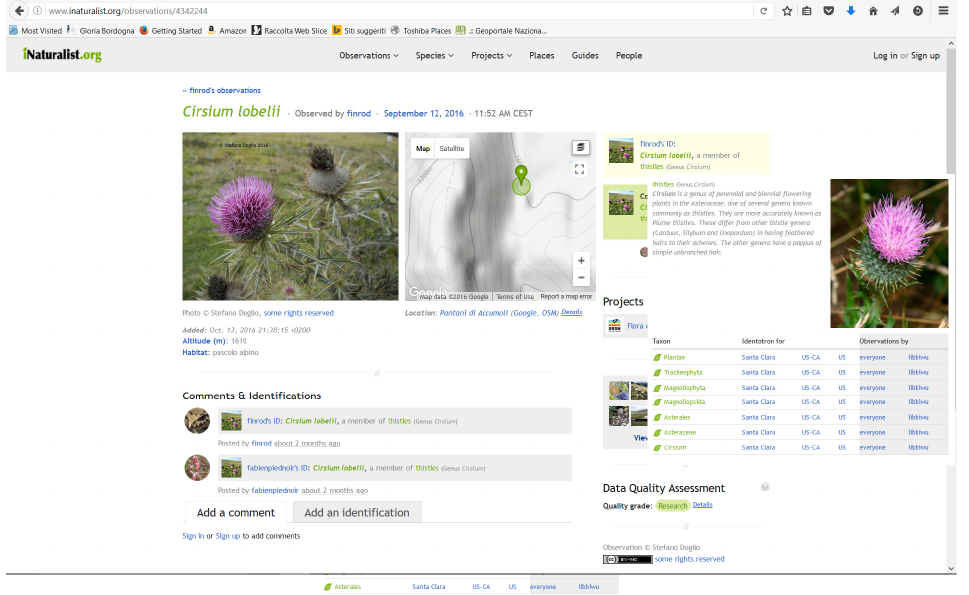
Figure 1. Screenshot of the inaturalist Web geoportal displaying a VGI in the form of a classified picture (on the left), its geofootprint with associated imprecision (the circle on the map) and the correspondent visual ontology item with complementary information on the species “Thistle” (on the right) [8].